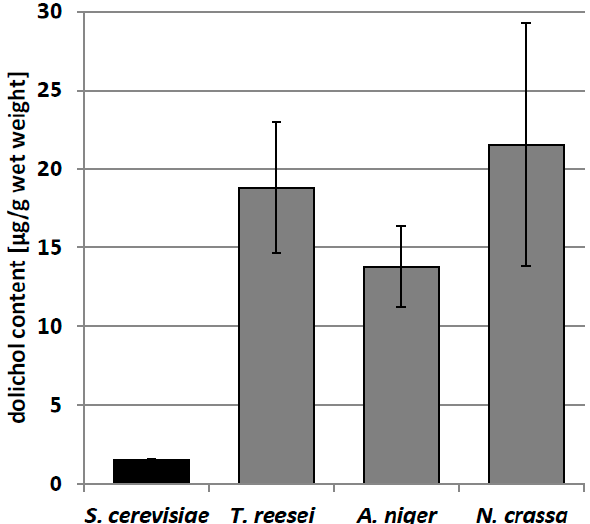
Figure 2. Dolichol content in yeast and filamentous fungi. Data are mean ± standard deviation from three independent experiments.